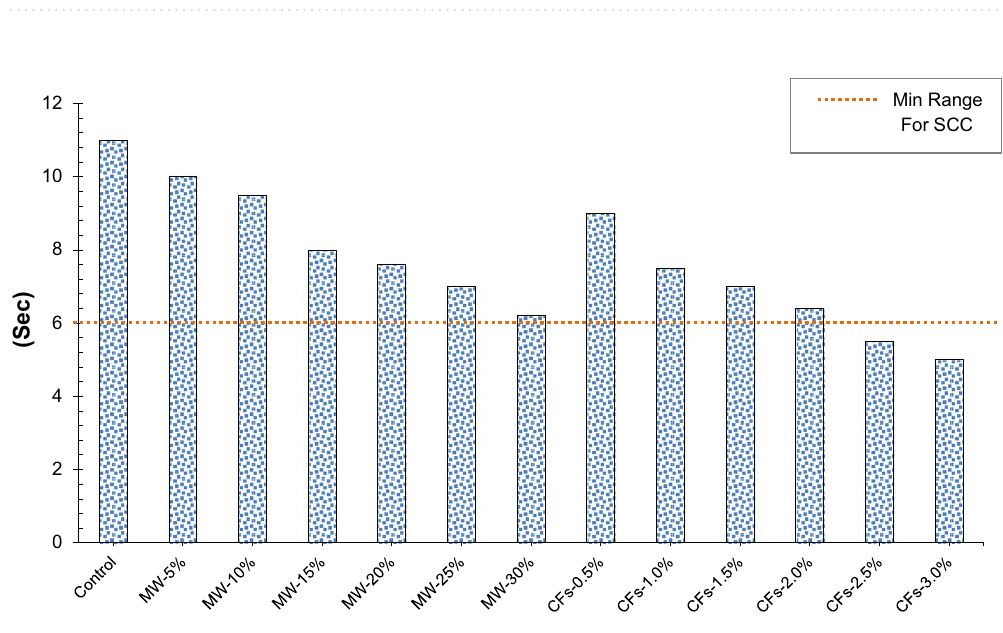
Figure 6. V funnel